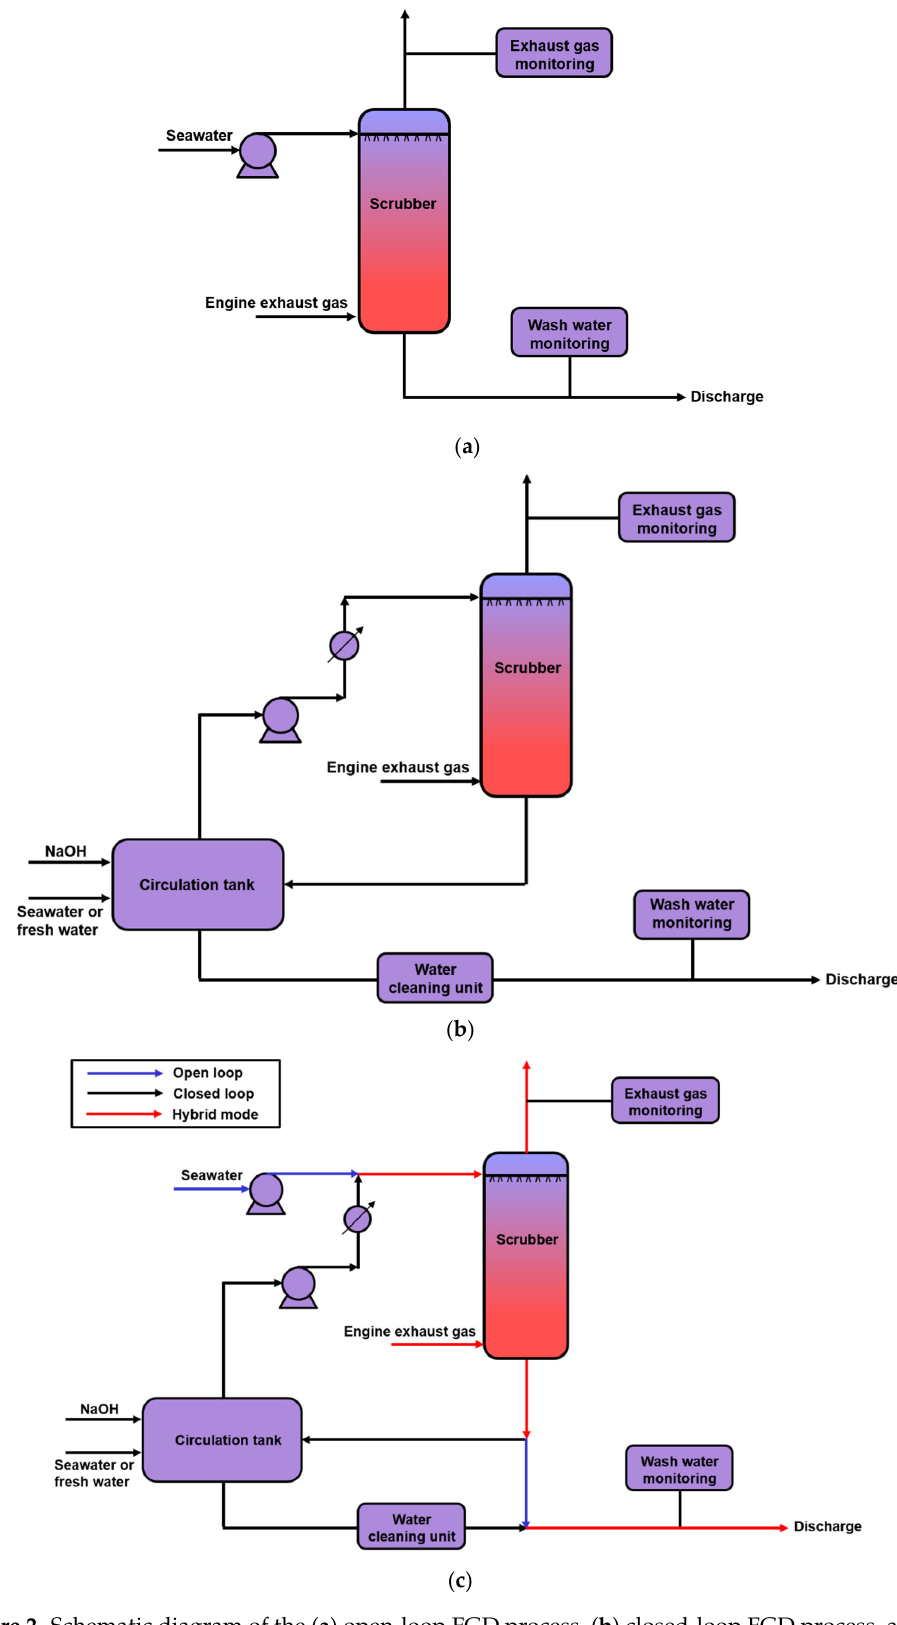
Figure 2. Schematic diagram of the ( a ) open-loop FGD process, ( b ) closed-loop FGD process, and ( c ) hybrid mode.